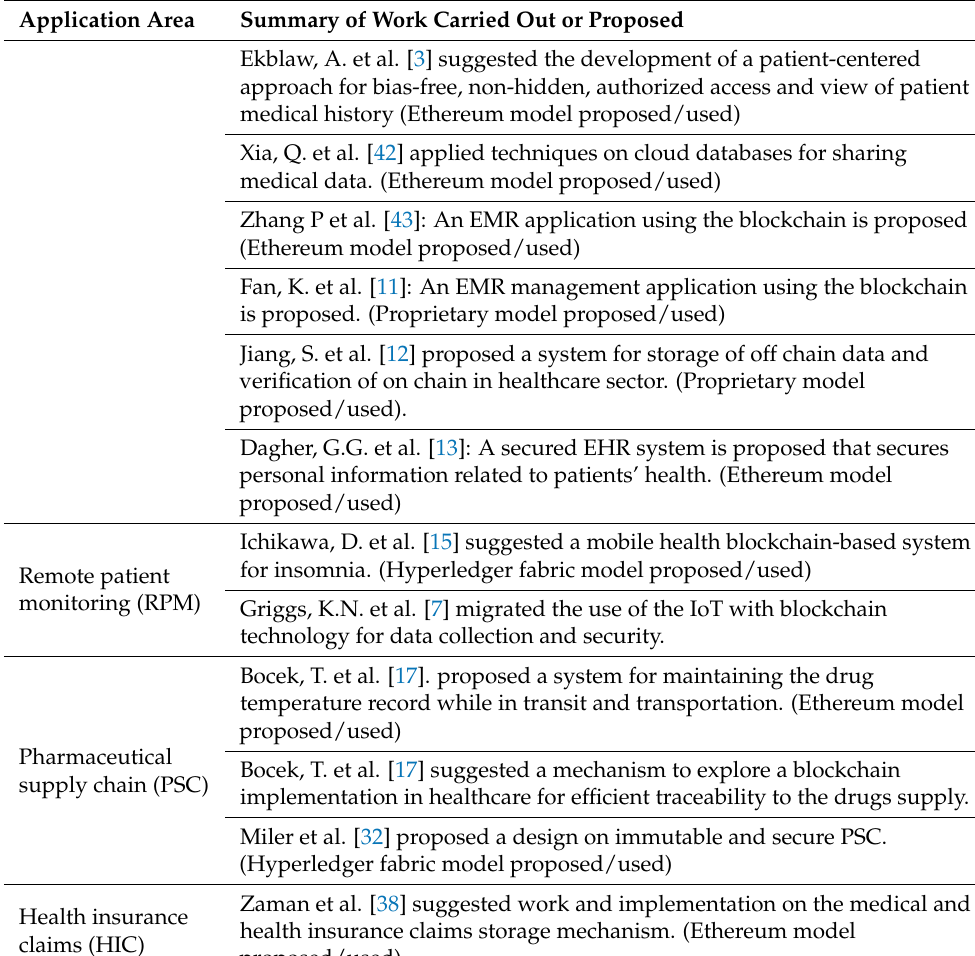
Table 1. Contributions of various researchers in the healthcare sector using the